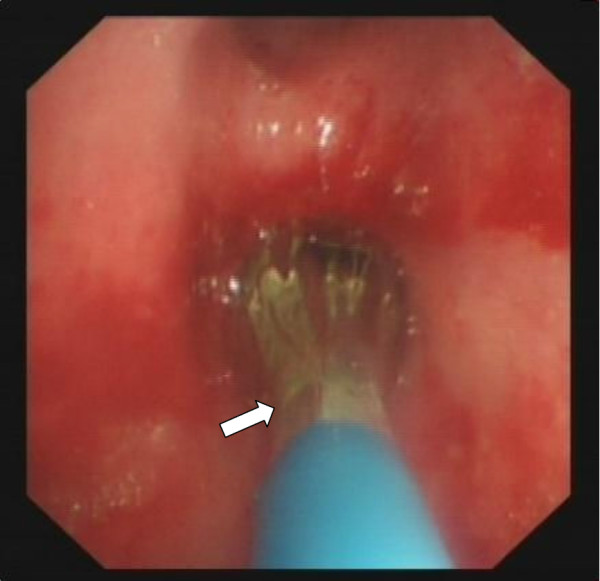
The balloon was at the narrow part of the intermedial segment bronchus (arrow). (2 November 2011)